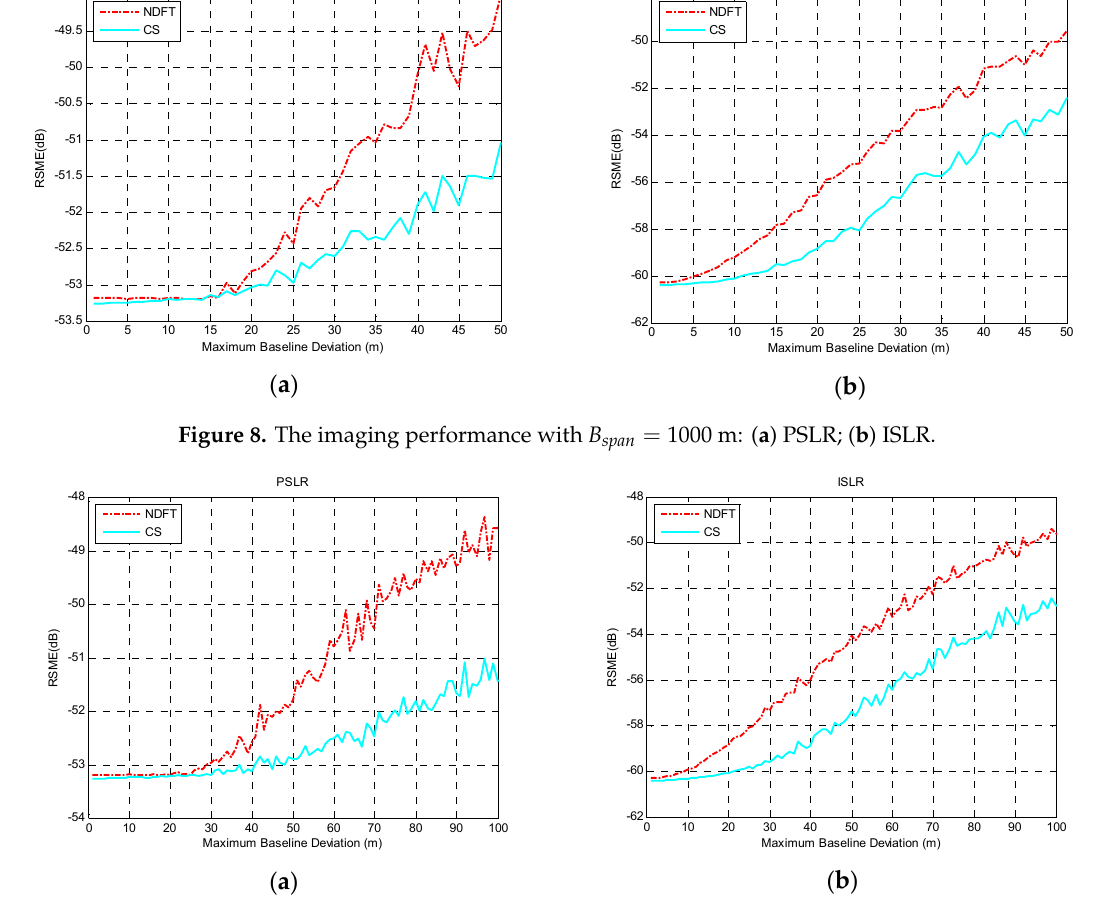
Figure 7. The imaging performance with